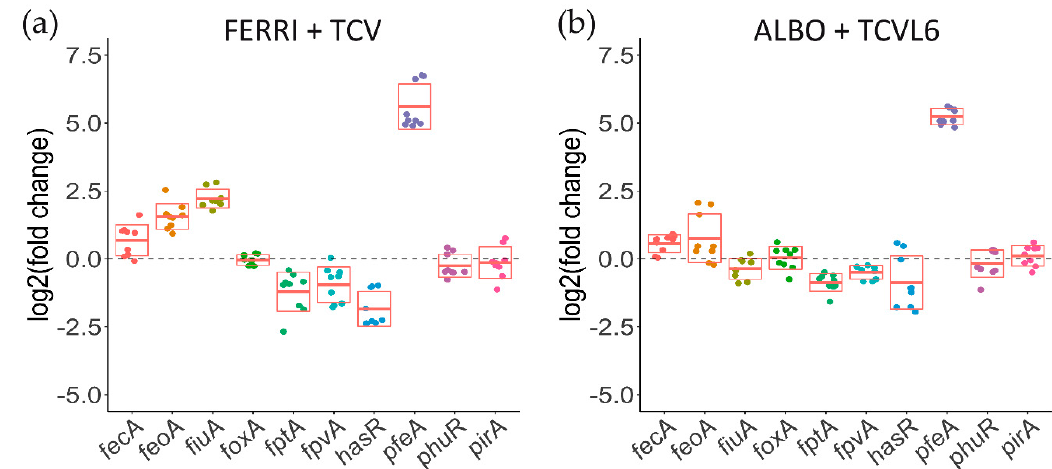
Figure 8. Analysis of the changes in the transcription of genes encoding OMTs involved in iron-uptake pathways in P. aeruginosa cells during A549 epithelial cell infection, in the presence or absence of a mixture of either FERRI and TCV ( a ) or ALBO and TCVL6 ( b ). RT-qPCR analyses were performed on P. aeruginosa PAO1 cells after 3 h of incubation with A549 epithelial cells in RPMI medium, with or without a mixture of two compounds: either FERRI and TCV or ALBO and TCVL6 (each of the compounds being present at a concentration of 10 µM). The data were normalized relative to the reference gene uvrD and are representative of three independent experiments, each performed in triplicate ( n = 3). Results are given as the ratio between the values obtained in the presence of the conjugates over those obtained in their absence. fecA encodes the OMT of ferri-citrate, feoA , the ferrous transporter, and fiuA , the OMT of FERRI, foxA, that of ferrioxamine B, fptA , that of PCH, fpvA , that of PVD, hasR and phuR , that of heme, pfeA and pirA , that of ENT, and piuA , that of an unknown siderophore.